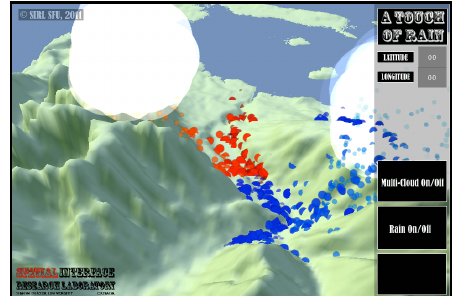
Figure 3. An early A Multi Touch of Rain prototype.